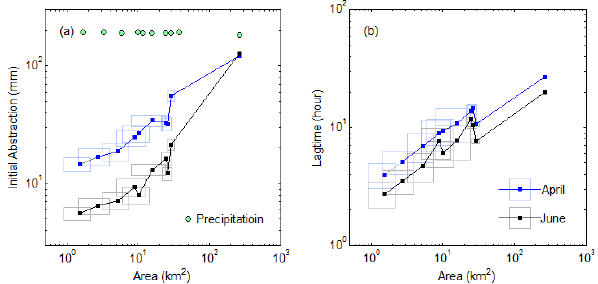
Fig. 7 Scaling property of HEC-HMS Calibrated parameters on hillslope I (Surface flow) 3 Fig. 7. Scaling property of HEC-HMS calibrated parameters on hill- 4 slope I (surface flow).